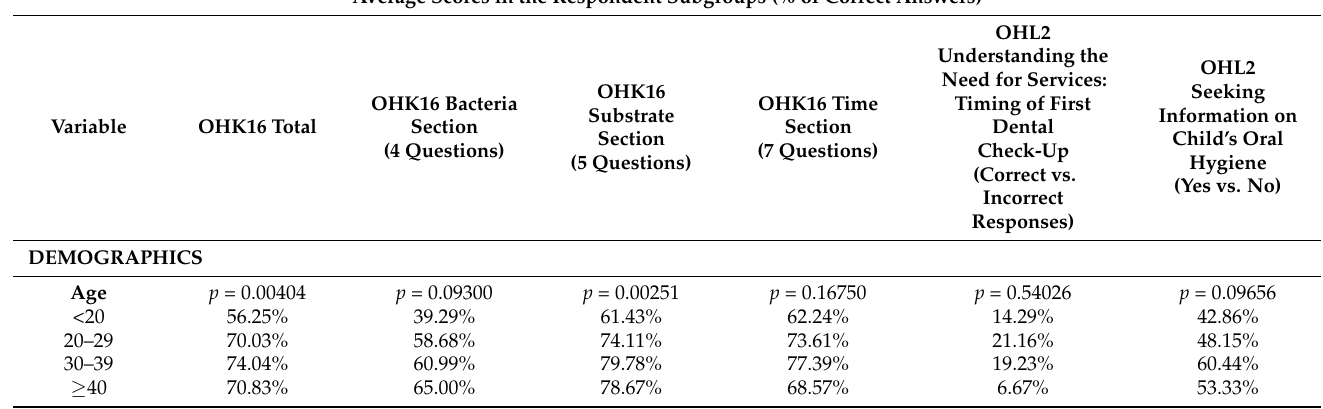
Table 3. Paediatric oral health knowledge and literacy vs. demographics, behaviours, and re- ported